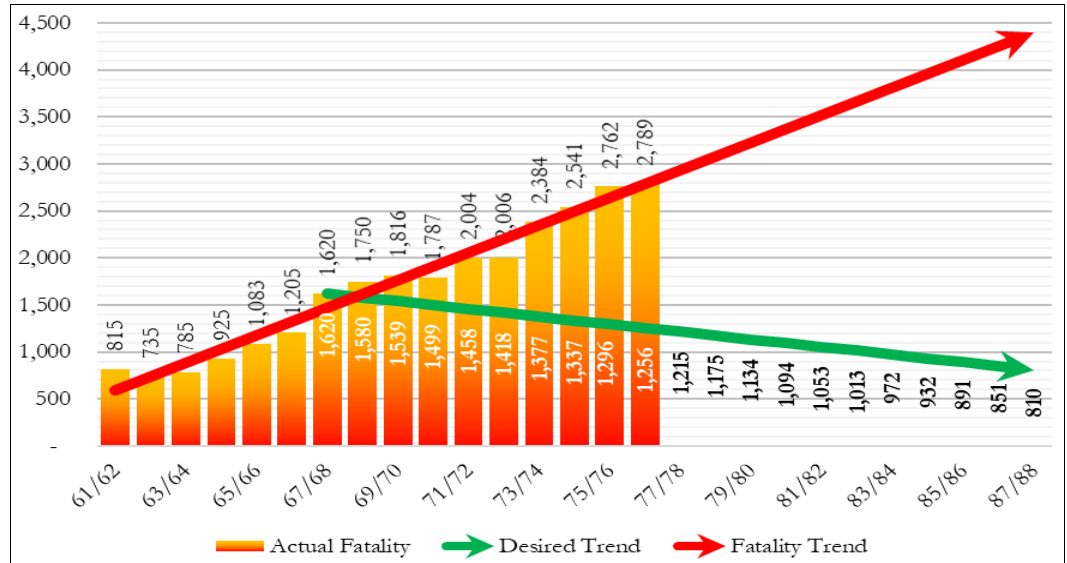
Figure 19: Gap Identification on targeted and actual fatality (BS 61/62 is equivalent to 2004/05 AD and BS 87/88 equivalent to